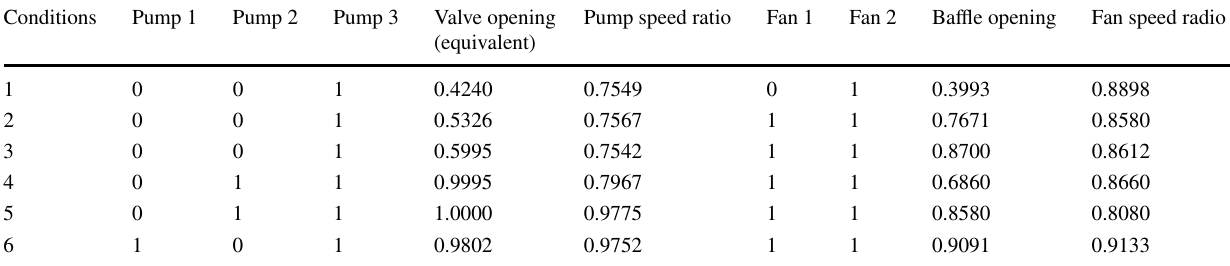
Table 6 The optimal operation plan for each working condition